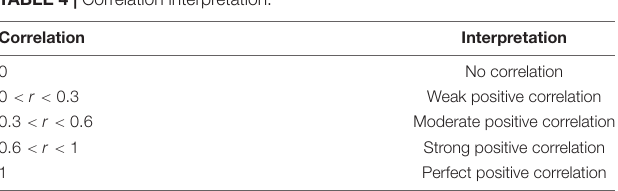
TABLE 3 | Correlation between Technological Pedagogical Content Knowledge (TPACK) and readiness. Constructs TK CK PK TCK TPK PCK TPACK Readiness 0.180* 0.208** 0.263** 0.384** 0.273** 0.285** 0.279** *Indicates significant at level 0.05. **Indicates significant at level 0.01. TABLE 4 | Correlation